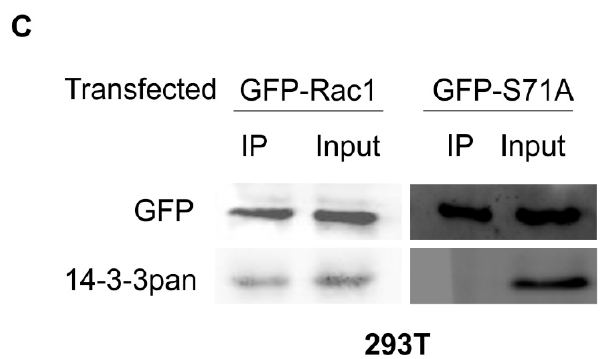
Figure 2. The e ff ects of Rac1 S71 mutation to A on the interaction between 14-3-3s and Rac1 in both Cos-7 and 293T cells. ( A ) The e ff ects of Rac1 S71 mutation to A on the interaction between 14-3-3s and Rac1 in Cos-7 cells. Cos-7 cells were transfected with wild type GFP-Rac1 and mutant GFP-S71A. The expressed Rac1 was immunoprecipitated (IPed) with an antibody to GFP, and the co-IPed 14-3-3s were examined by immunoblotting. ( B ) The e ff ects of Rac1 S71 mutation to A on the interaction between 14-3-3s and Rac1 in Cos-7 cells by GST pulldown. The Cos-7 lysates were incubated with glutathione-agarose beads charged with GST, GST-Rac1 or mutant GST-S71A. The agarose beads were then separated and subjected to immunoblotting analysis with an antibody against 14-3-3 and GST. ( C ) The e ff ects of Rac1 S71 mutation to A on the interaction between 14-3-3s and Rac1 in 293T cells. 293T cells were transfected with either GFP-Rac1 or GFP-S71A. GFP-Rac1 and GFP-S71A were